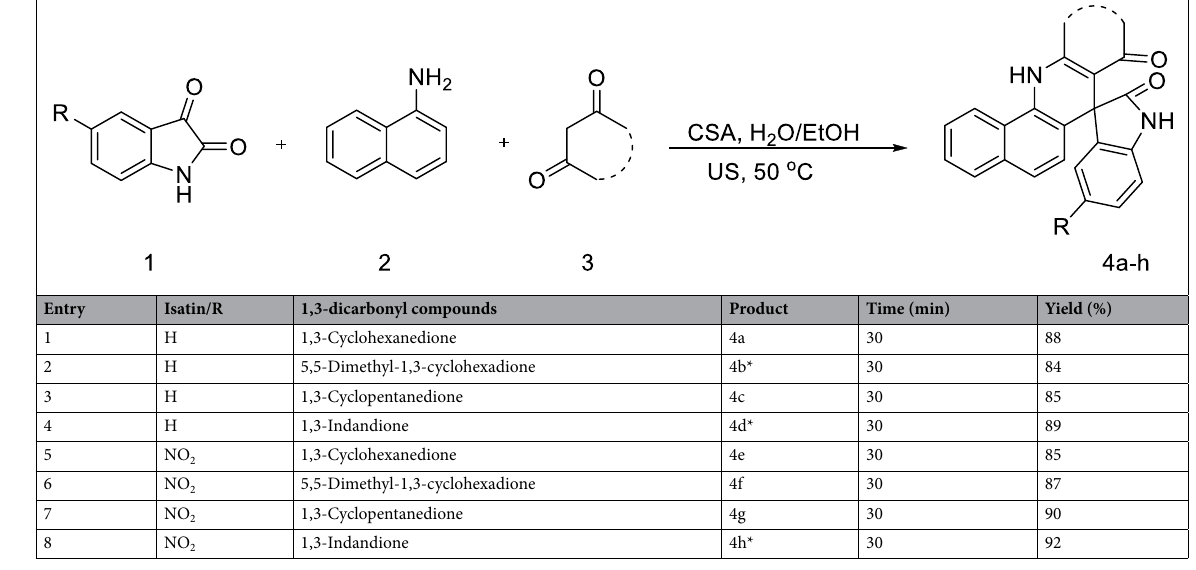
Table 2. Synthesis of spiroquinoline-indoline-dione (Spirooxindole) derivatives in the presence of catalyst ( ±)-CSA. *These compounds were synthesized by another method in the literature 44 .